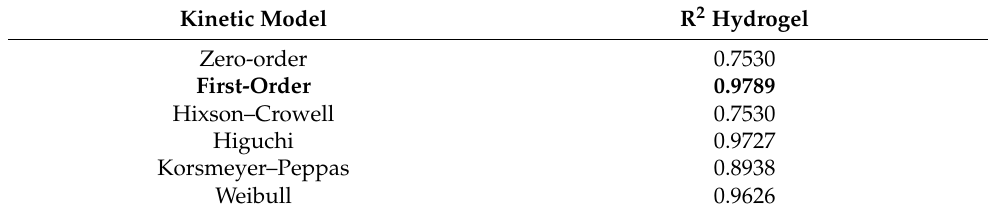
Table 4. Values of coefficients of determination obtained for all the kinetic models used.